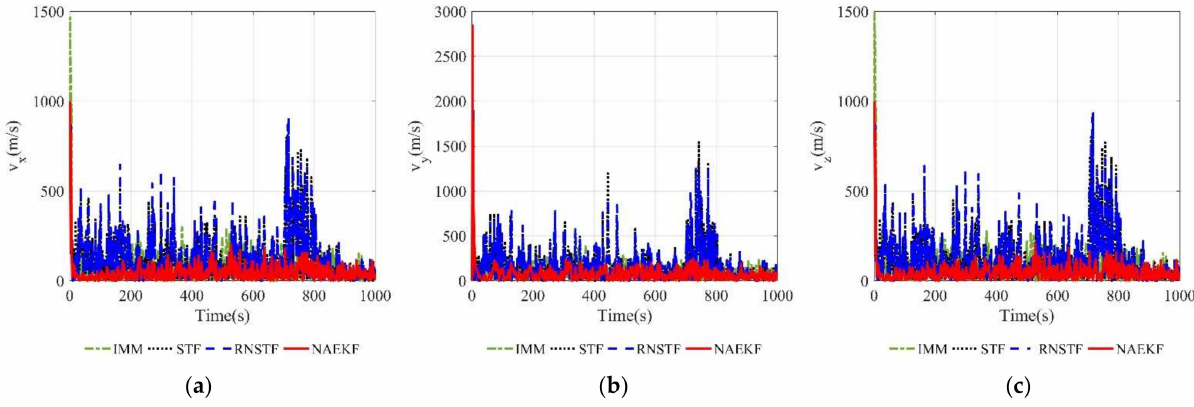
Figure 21. Velocity estimation errors. ( a ) Estimation errors of v x ; ( b ) Estimation errors of v y ; ( c ) Estimation errors of v z